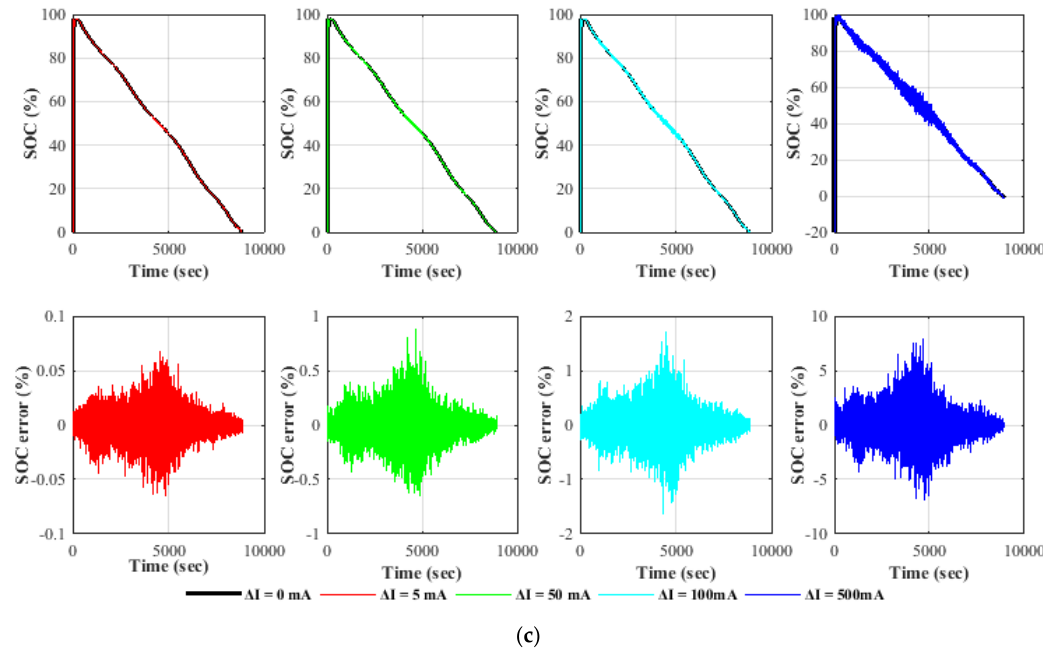
Figure 6. Estimated values at different precision of current sensors: ( a ) model parameters; ( b ) estimated OCV; ( c ) estimated SOC.